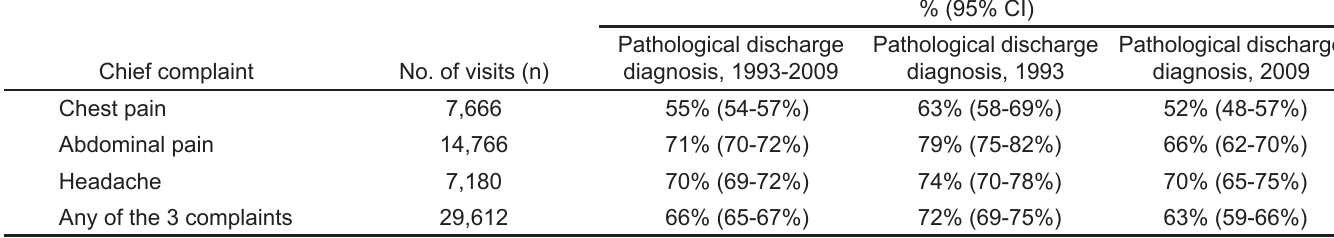
Table 1. Proportion of pathological discharge diagnosis for the three most common chief complaints among U.S. emergency department visits, 1993-2009.